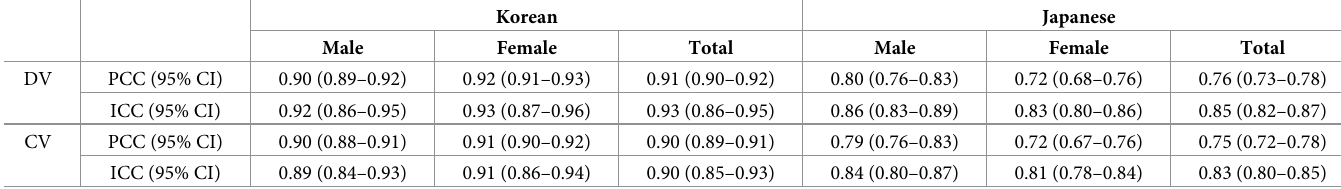
DV, discrete variable; CV, continuous variable; CI, confidence interval. Pearson correlation coefficients (PCCs) and interclass correlation coefficients (ICCs) were calculated based on age estimation using M2s and M3s in both jaws. The data using single molar, or two combined molars are presented in S2 Table. All point estimates are P <